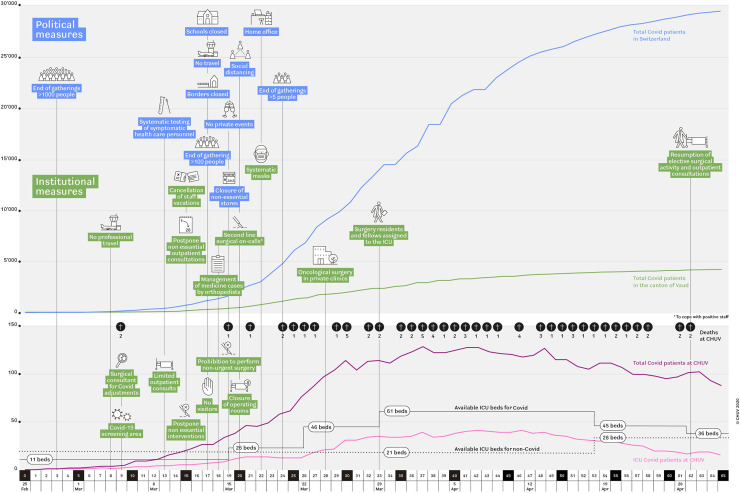
Synopsis of Covid-19 pandemic in University Hospital CHUV, Lausanne.